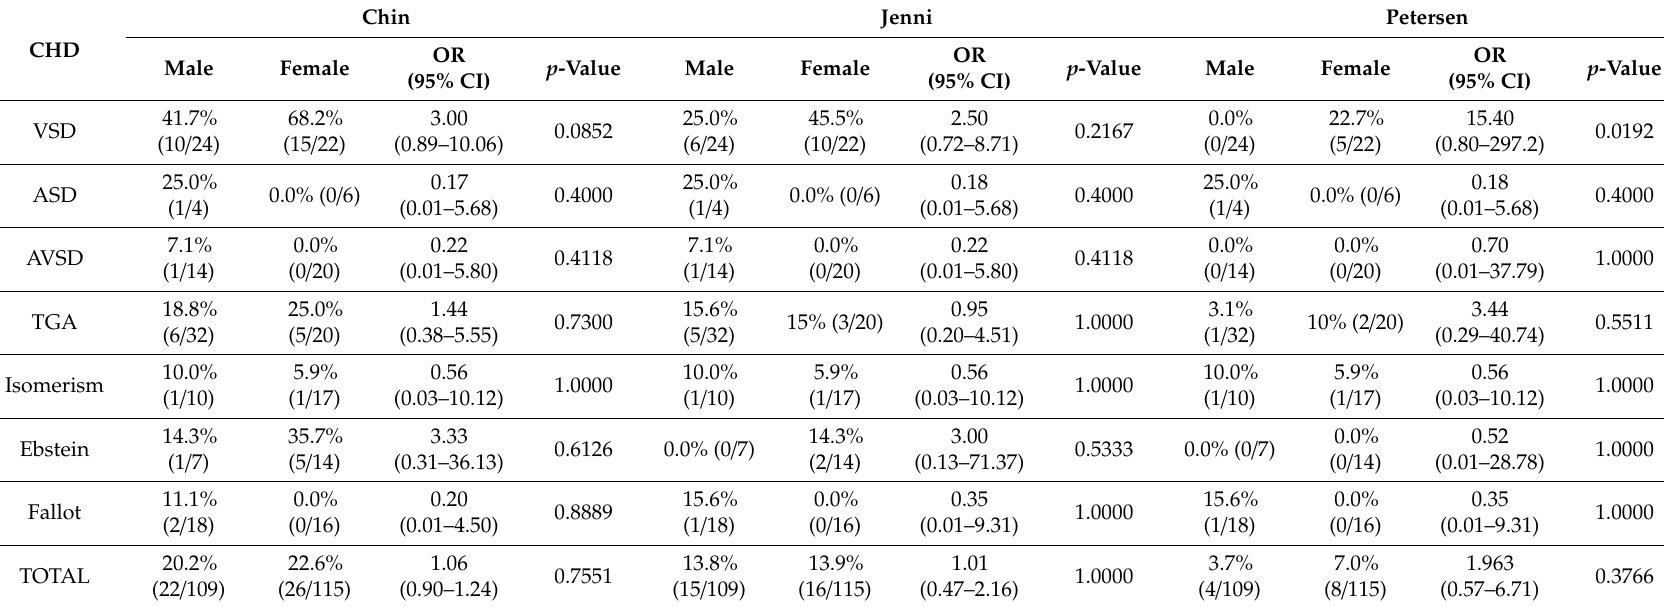
Table 9. Percentage of hearts presenting LVNC according to Chin, Jenni, and Petersen when stratified by sex